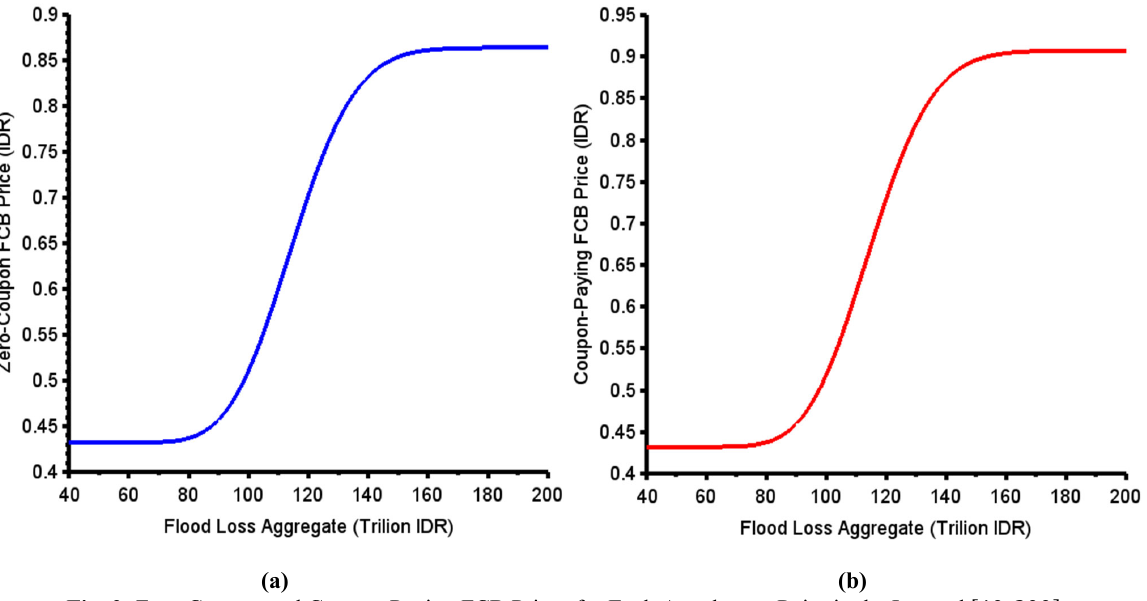
Fig. 3 . Zero-Coupon and Coupon-Paying FCB Prices for Each Attachment Point in the Interval (cid:4670) 40, 200